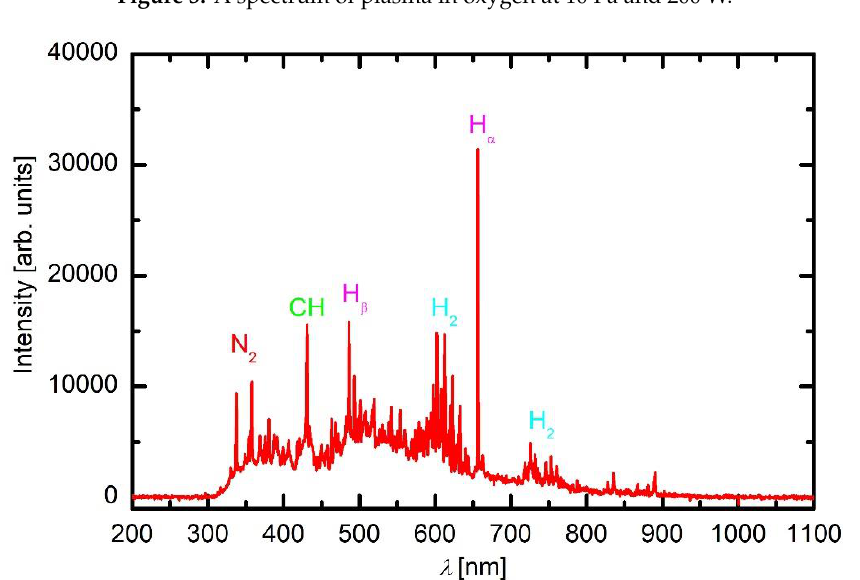
Figure 4. A spectrum of plasma in HMDSO at 10 Pa and 200 W.